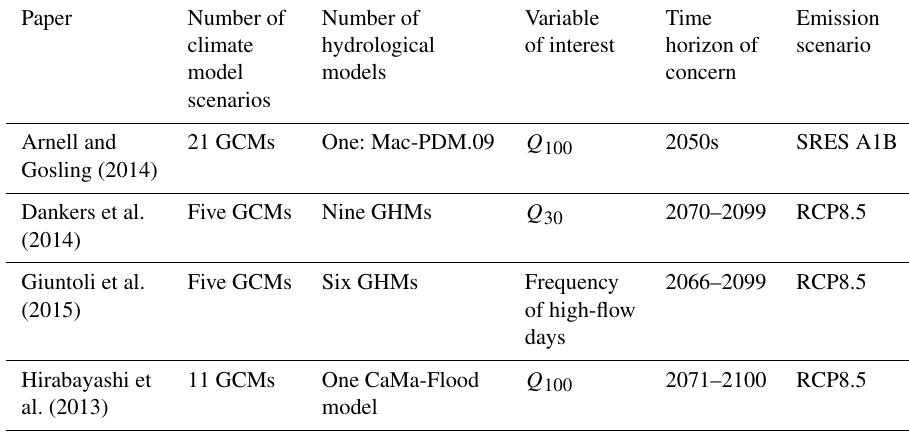
Table 2. Assumptions made in model-based global flood hazard projection